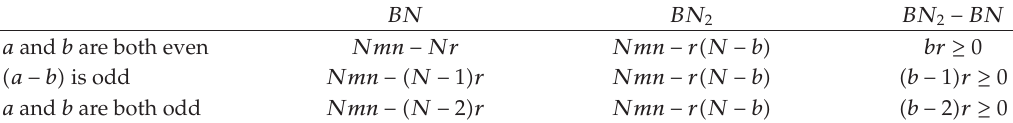
Table 1: Comparisons of BN and BN 2 (cid:2) where a ≥ b ≥ 2 and N (cid:5) ab (cid:4) . BN BN 2 BN 2 −